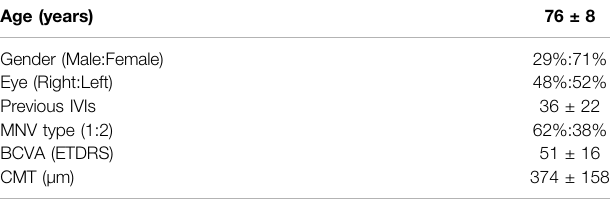
TABLE 1 | Baseline characteristics of the study group (mean ± SD). Age (years) 76 ± 8 Gender (Male:Female) 29%:71% Eye